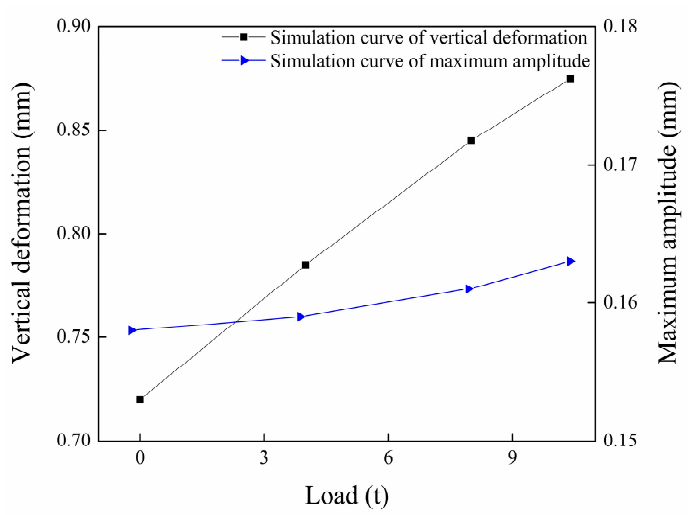
Figure 11. The impact response curves of the wheel flat under different loads.